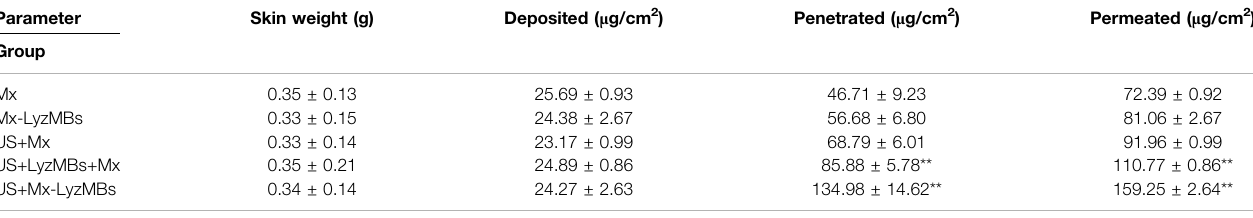
TABLE 2| AmountsofMxthatafter 18 hhadpermeatedtheskin,depositedontheskin,andpenetratedacrosstheskin.TheconcentrationofMxwassigni fi canthigher (** p < 0.01) in the US+Mx-LyzMBs group and the US+LyzMBs+Mx group than in the US+Mx, Mx-LyzMBs, Mx, and LyzMBs groups. The concentration did not differ signi fi cantly between the US+Mx and Mx-LyzMBs groups or between the Mx-LyzMBs and Mx groups ( p > 0.05). The amount of Mx deposited in the skin did not differ signi fi cantly among all of the groups after 18 h ( p > 0.05). Data are mean ± SEM values. Parameter